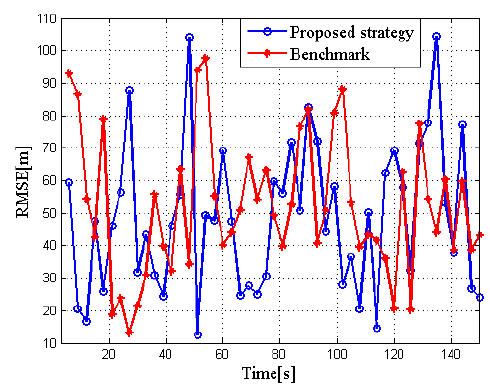
Figure 6. Root mean squared error (RMSE) in two algorithms for target tracking in RCS case 1.